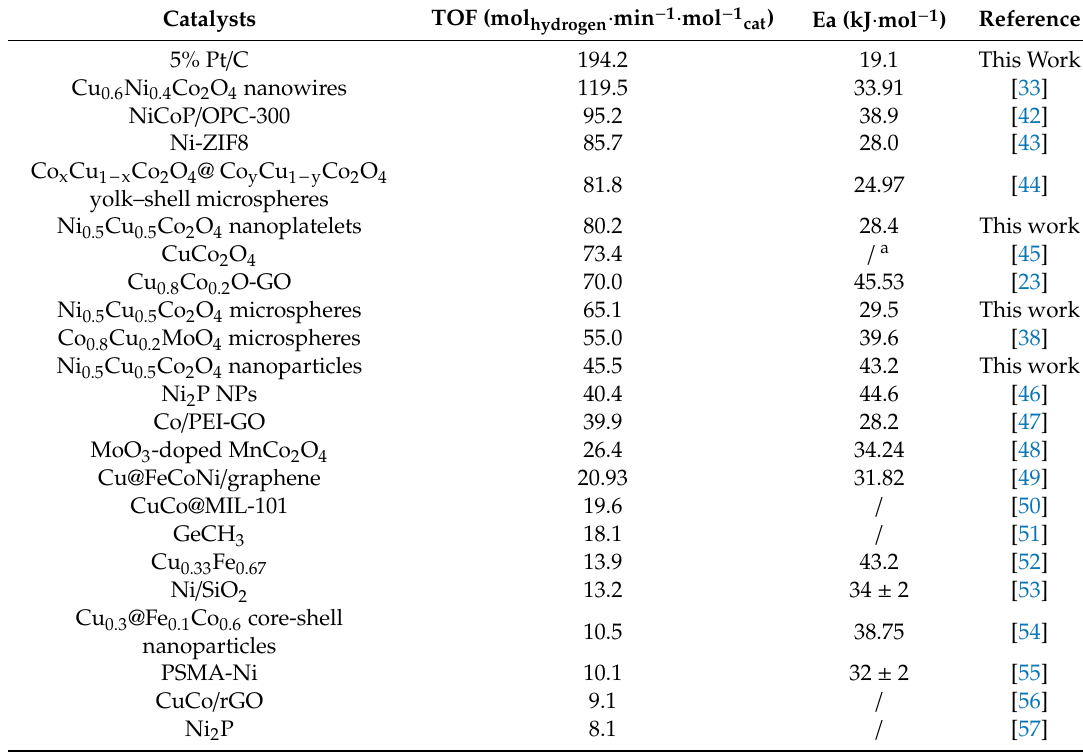
Figure 7. Deconvoluted H 2 –TPR profiles of different Ni 0.5 Cu 0.5 Co 2 O 4 nanocomposites: nanoparticles ( a ), microspheres ( b ), and nanoplatelets ( c ). Table 1. TOF and Ea of some representative non-noble catalysts and commercial Pt / C toward AB